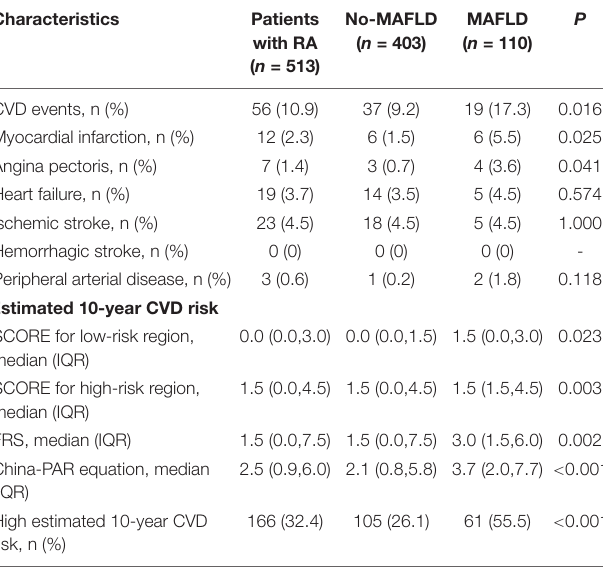
MAFLD, metabolic dysfunction-associated fatty liver disease; CVD, cardiovascular disease; SCORE, the Systemic Coronary Risk Evaluation; FRS, Framingham Risk Score; China-PAR, the Prediction for ASCVD Risk in China; IQR, interquartile